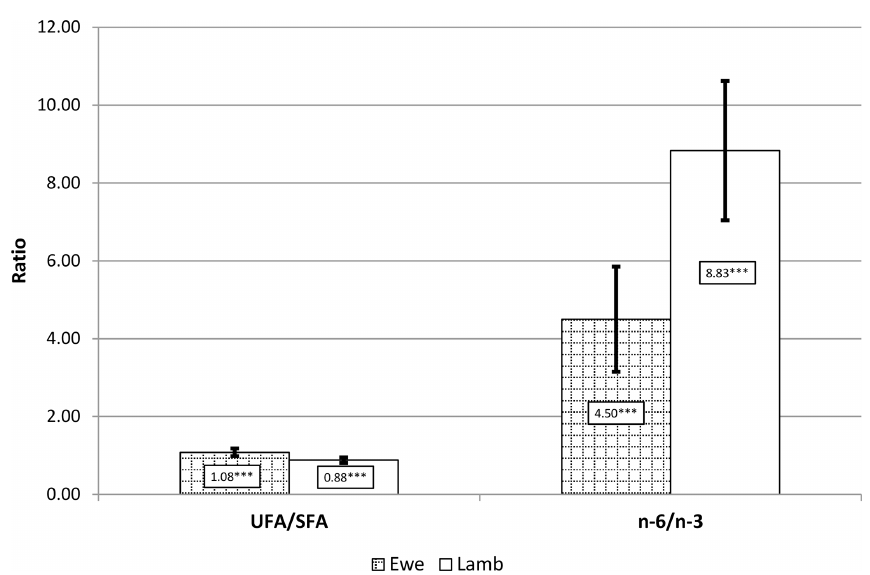
Figure 1. UFA / SFA and n-6 / n-3 FA ratios of ewe and lamb musculus biceps femoris meat (mean ± SD). The asterisks indicate significance values ≤ 0 .